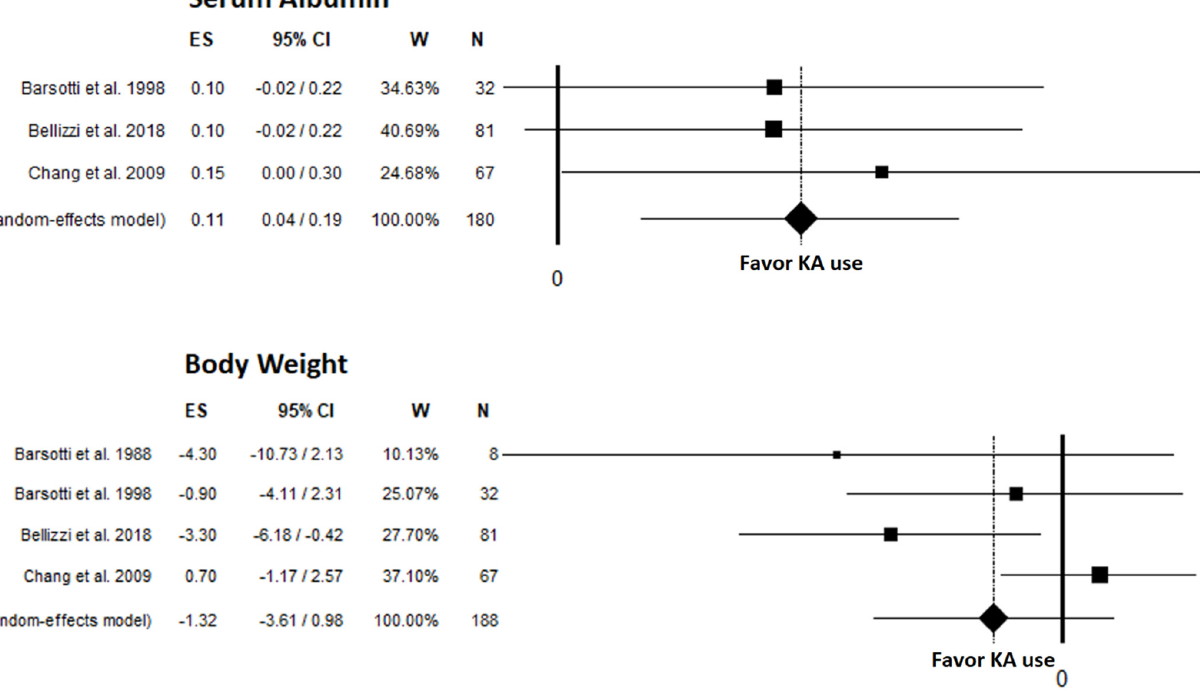
Figure 4. Meta-analyses for nutritional outcomes reported in studies included in the systematic